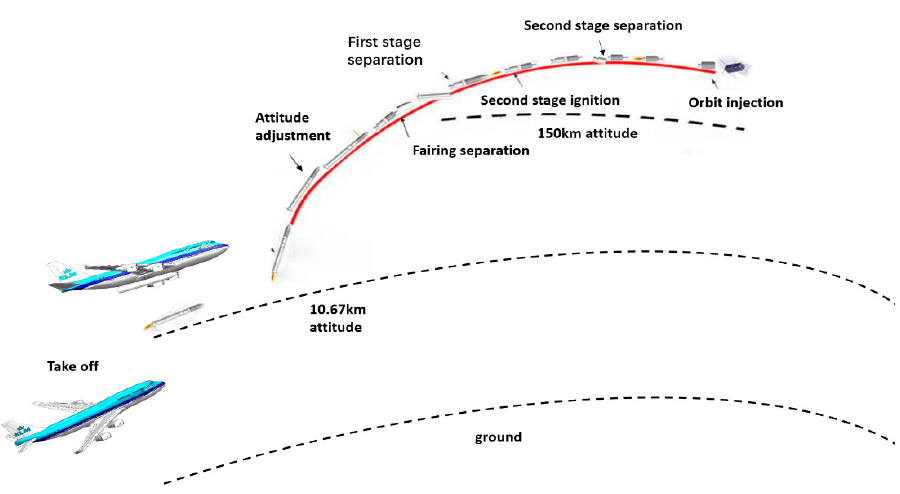
Figure 3. The flight process of the three-stage rocket.